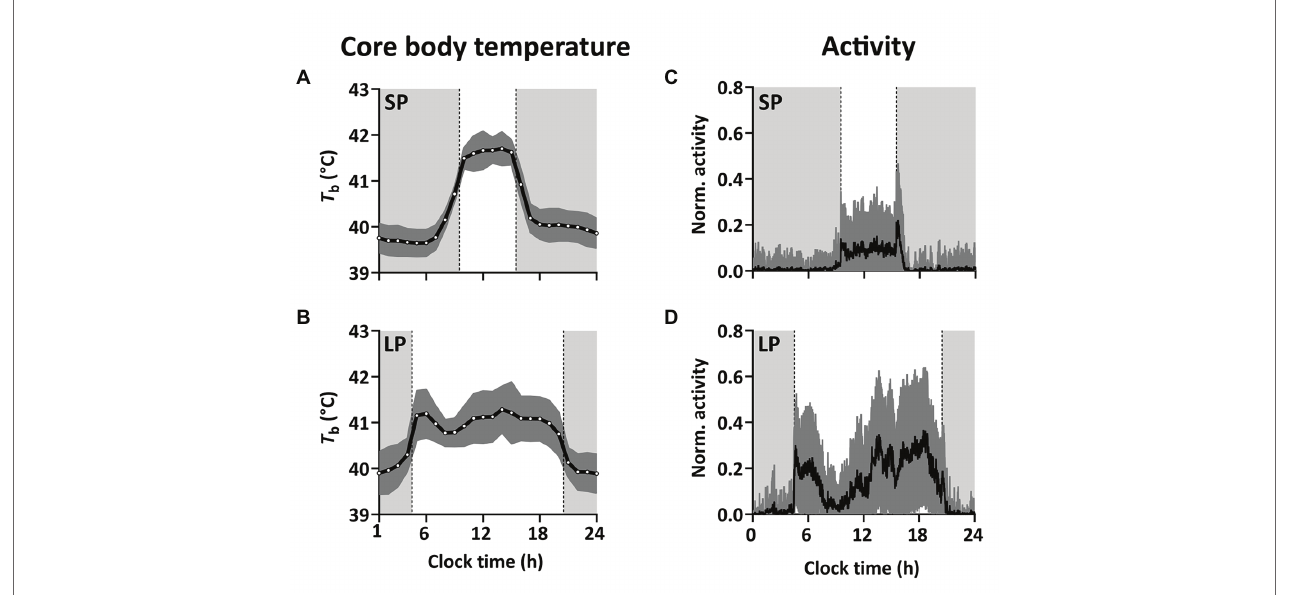
FIGURE 3 | Diel variation in T b and activity in short and long photoperiod. (A,B) Mean ± SD T b over the course of 24 h (01:00 to midnight) in SP (based on 222 × 24-h recordings from five birds) and LP (based on 184 × 24-h recordings from eight birds). T b was measured every hour throughout the experiment. (C,D) Mean normalized activity ± SD over the course of 24 h (midnight to midnight) in SP (61 × 24-h recordings from three birds) and LP (27 × 24-h recordings from three birds). Light gray shadowing in the panels indicate periods of darkness and dark gray indicates